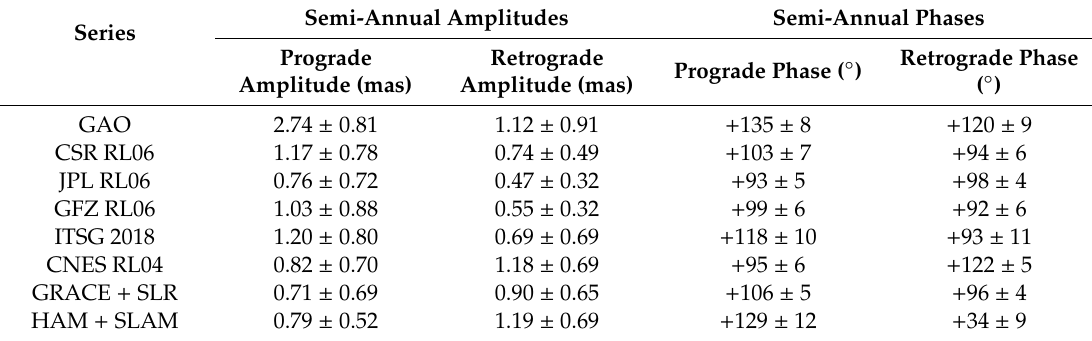
Table A3. Amplitudes and phases of prograde and retrograde semi-annual oscillations of GAO, GSM, and HAM + SLAM together with their errors. The phases refer to the reference epoch starting on 1 January 2004.